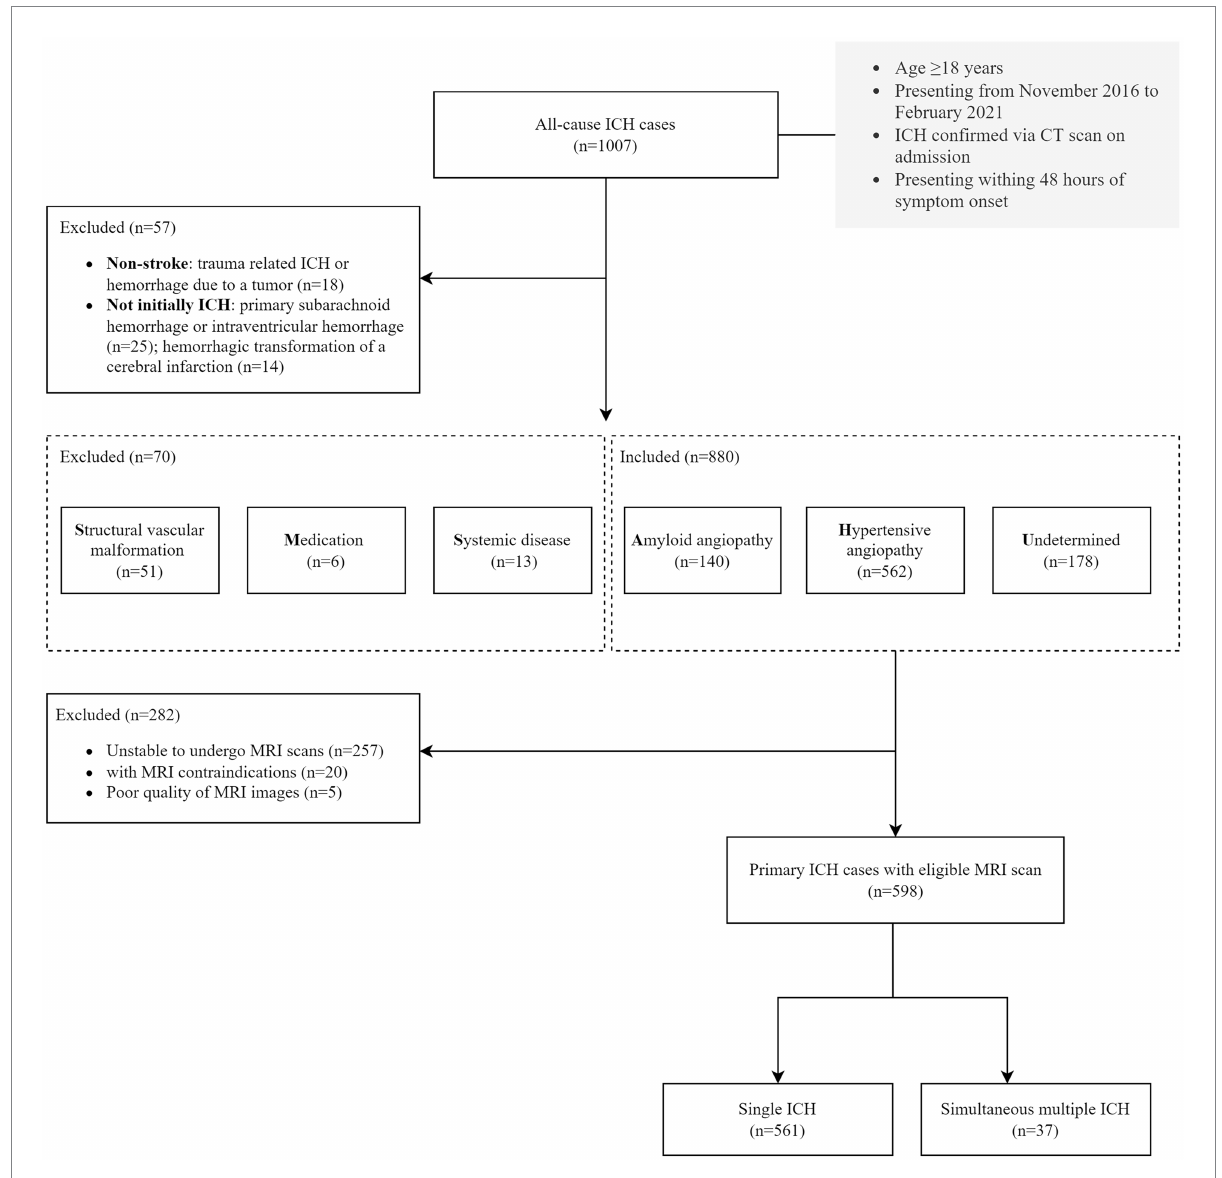
FIGURE 1 Flow chart of the study